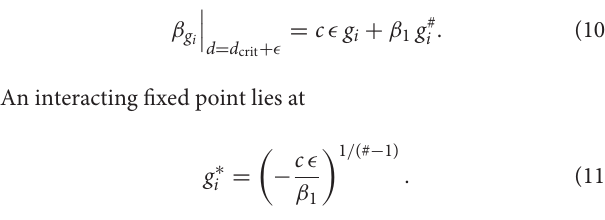
gy 2 g 2 g 2 and β y 2 y 3 feature a fixed point at g = − = − + 2 g 2 g 2 and β g 2 2 g 2 2 g 2 2 features a fixed point at g = − = − + 1 for the trajectories emanating from this fixed =